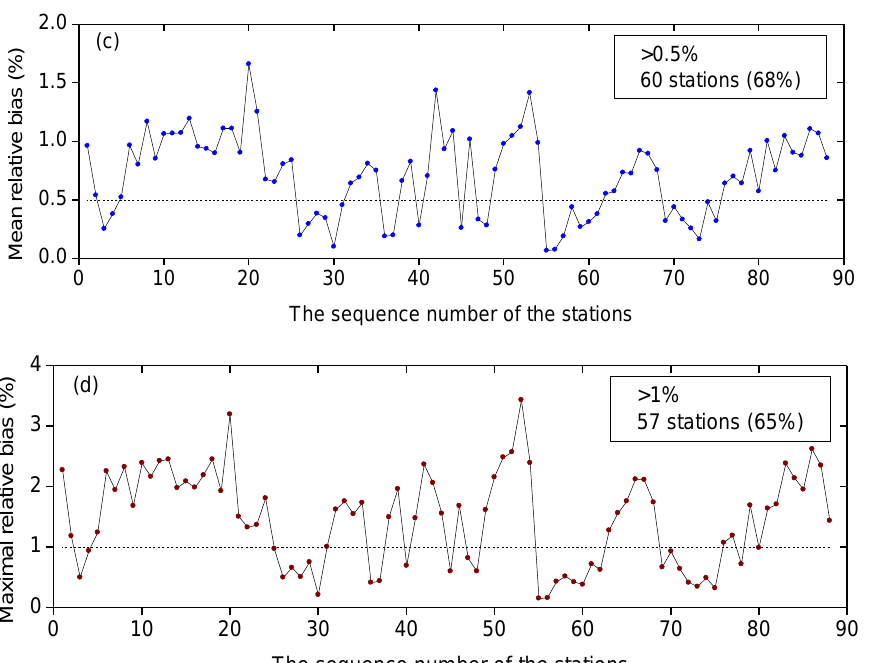
Figure 4. Differences between the unified model and each site-specific model. The bias is the absolute value of the difference between unified-model T m and site-specific-model T m . The relative bias is defined as the bias divided by the site-specific-model T m value. For each station, the mean ( a ) and maximum ( b ) of the biases, as well as the mean ( c ) and maximum ( d ) of the relative biases, are shown. The horizontal axis of each plot is the sequence number of the radiosonde stations. The